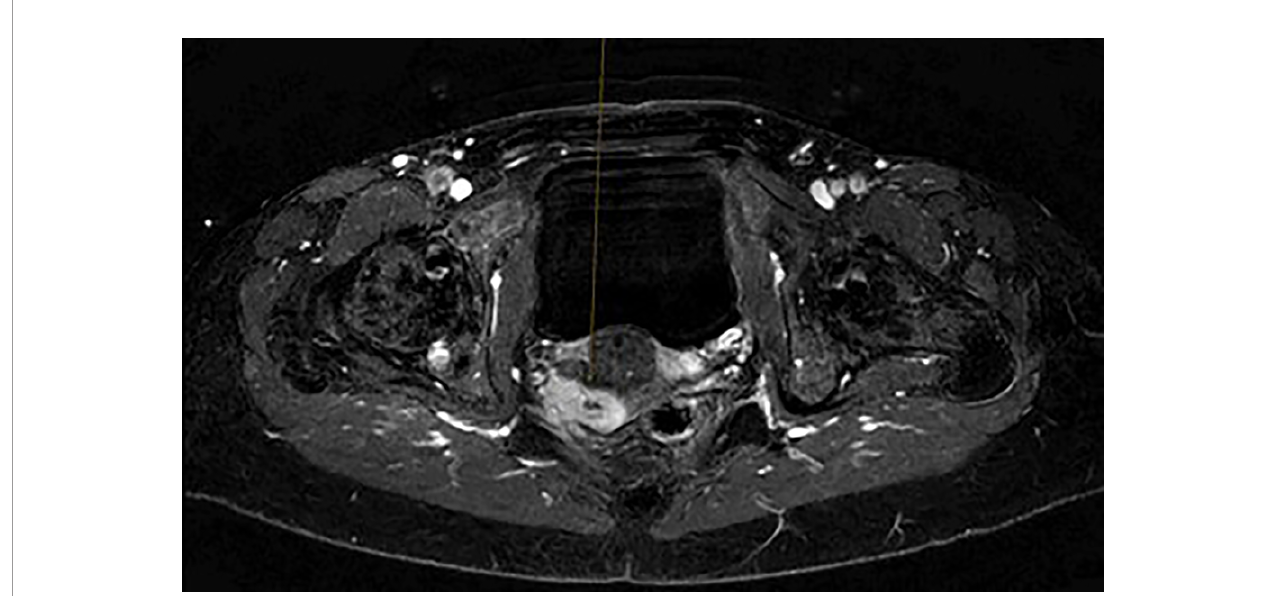
FIGURE 1 | Initial magnet resonance Imaging scan of the